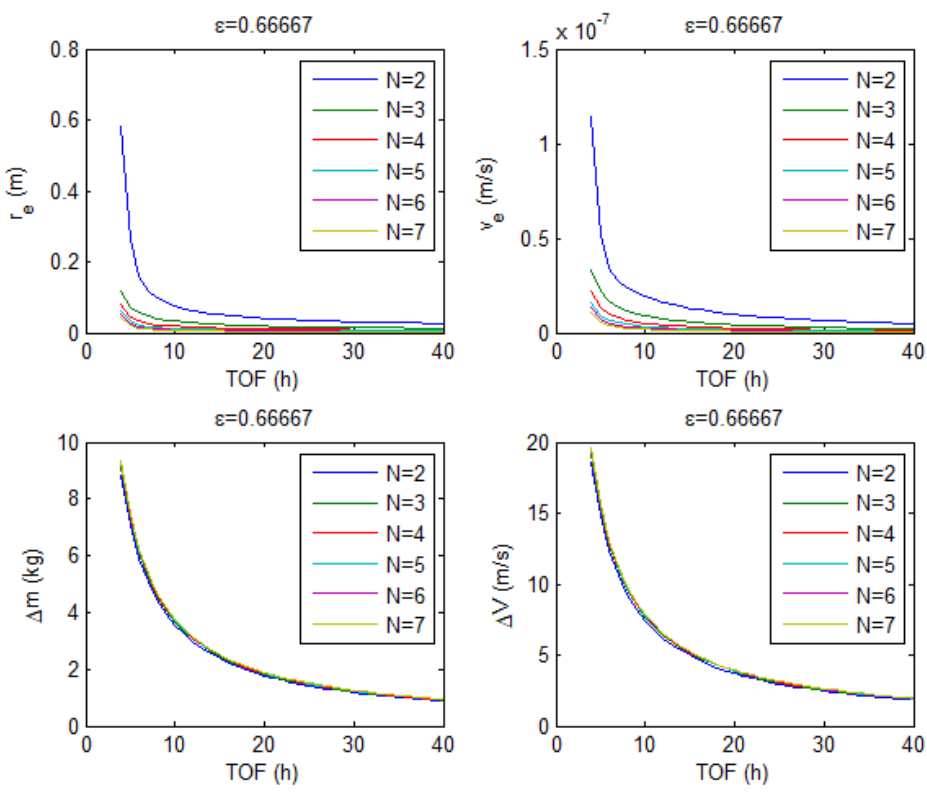
ε ). Figure 4. Control performances (baseline trajectory, ε = 2 ). 3 3